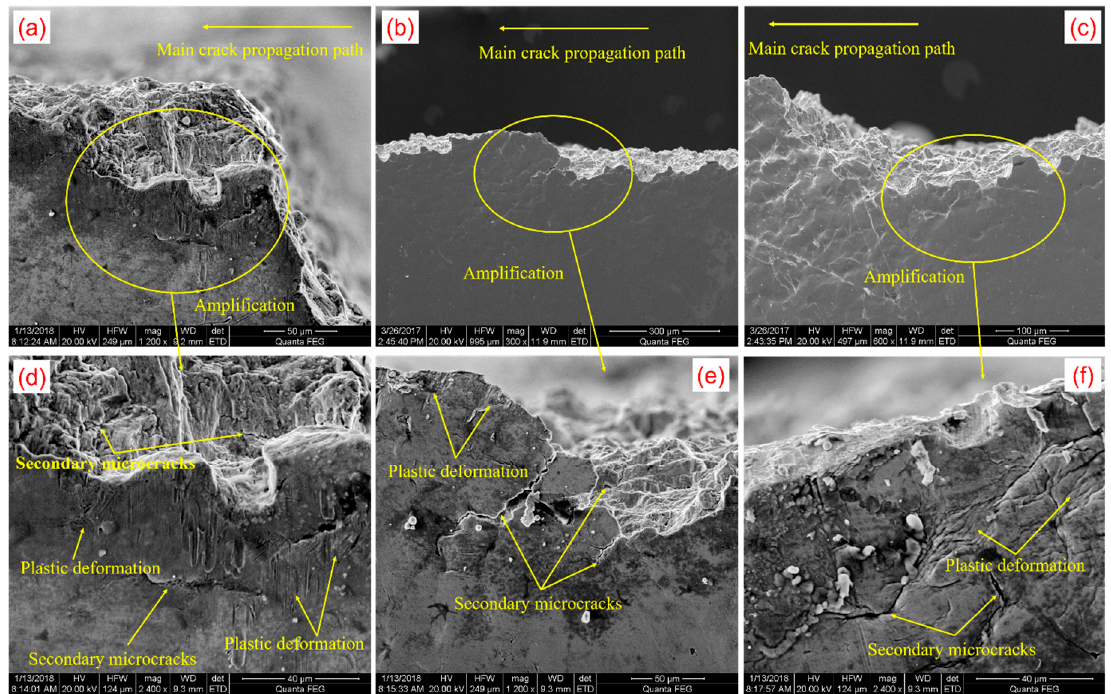
Figure 8. Morphologies of specimen surface through SEM along the main crack propagation: ( a ) crack initiation zone; ( b ) crack propagation zone; ( c ) final fracture ( d ) amplification of the crack initiation zone; ( e ) amplification of the crack propagation zone; and ( f ) amplification of the final fracture zone.